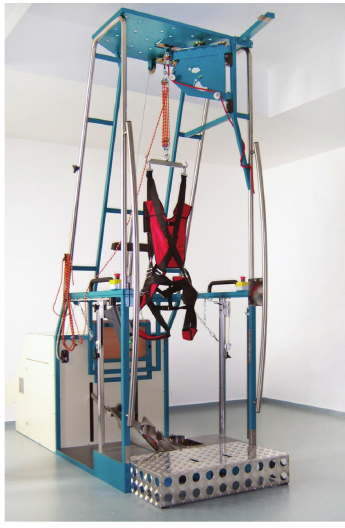
Figure 5: The Gangtrainer GT I (picture courtesy of Reha-Stim).